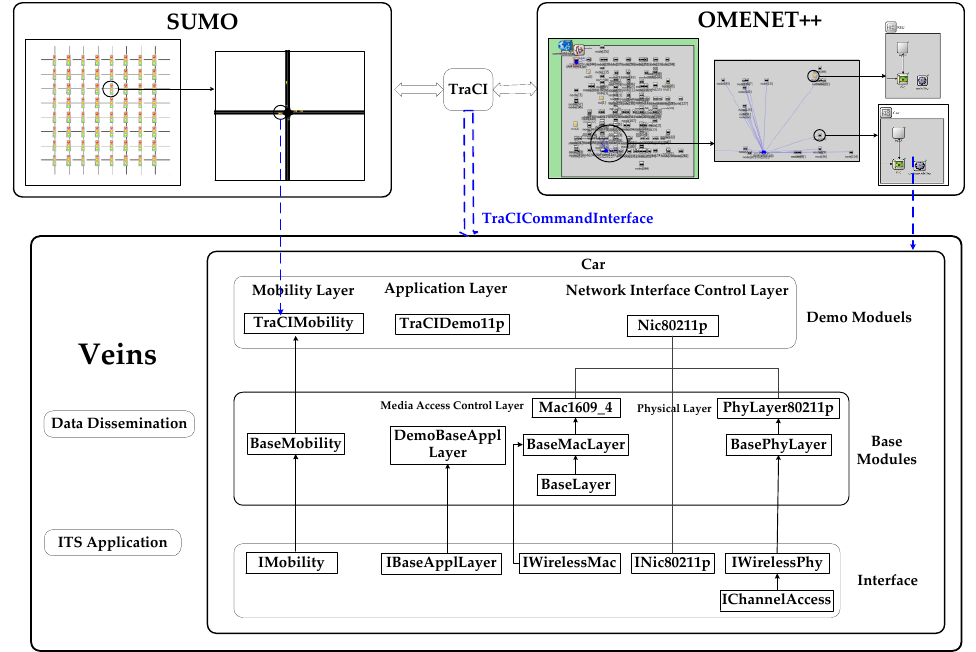
Figure 17. Roadside Units Deployment (RSUD) schemes obtained by Center-Rule-Based Neighborhood Search Algorithm ( CNSA): ( a ) 8 × 8 intersections, 8 RSUs; ( b ) 8 × 8 intersections, 16 RSUs; ( c ) 12 × 12 intersections, 8 RSUs; ( d ) 12 × 12 intersections, 16 RSUs.